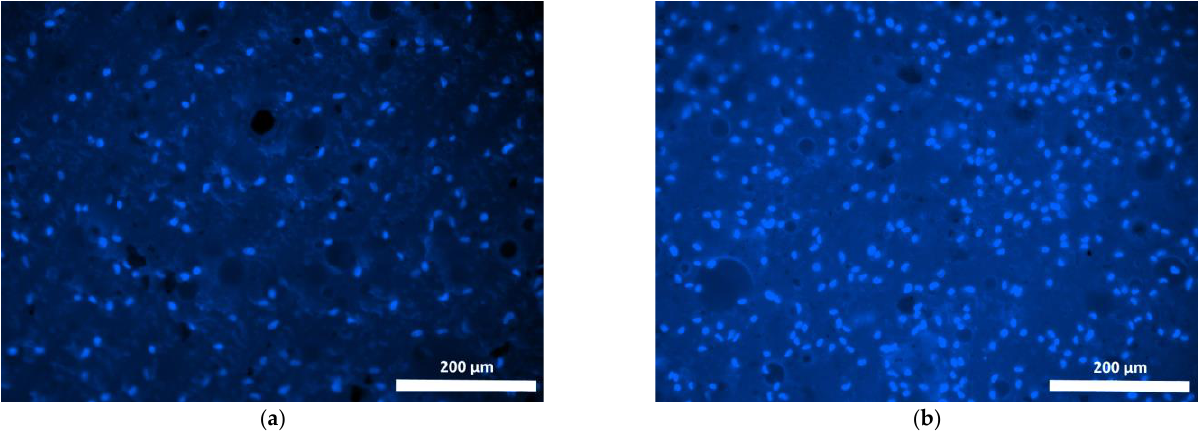
Figure 11. Fibroblast nuclei on the surface of Composition 4 specimen (fluorescence microscopy, fluorochrome — Hoechst 3334, BD Pharmingen ™ ): ( a ) 24 h cultivation; ( b ) 72 h cultivation. Mag. 100 ×.